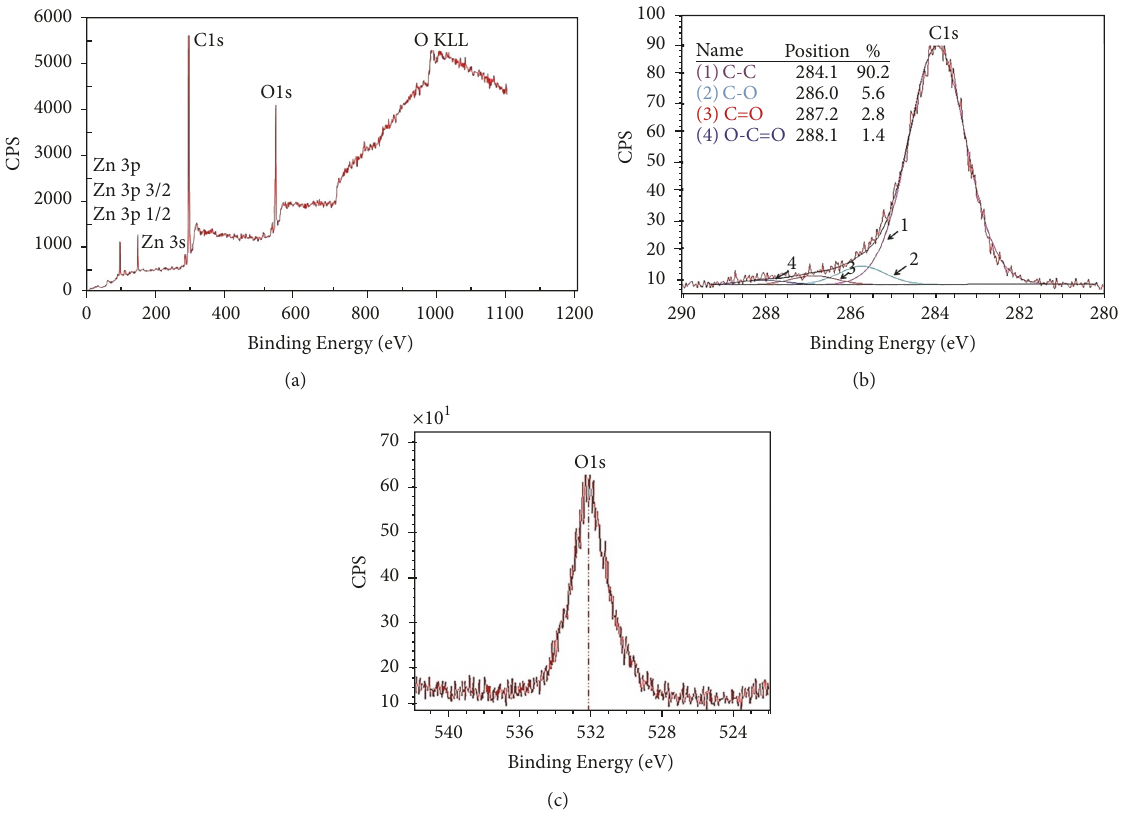
Figure 7: XPS spectra of rGO-Zn coating produced by pulse-potential electrodeposition method (a) survey spectrum of the coating with three major peaks of carbon, oxygen, and zinc. XPS high resolution survey of (b) C1s and (c) O1s peaks of